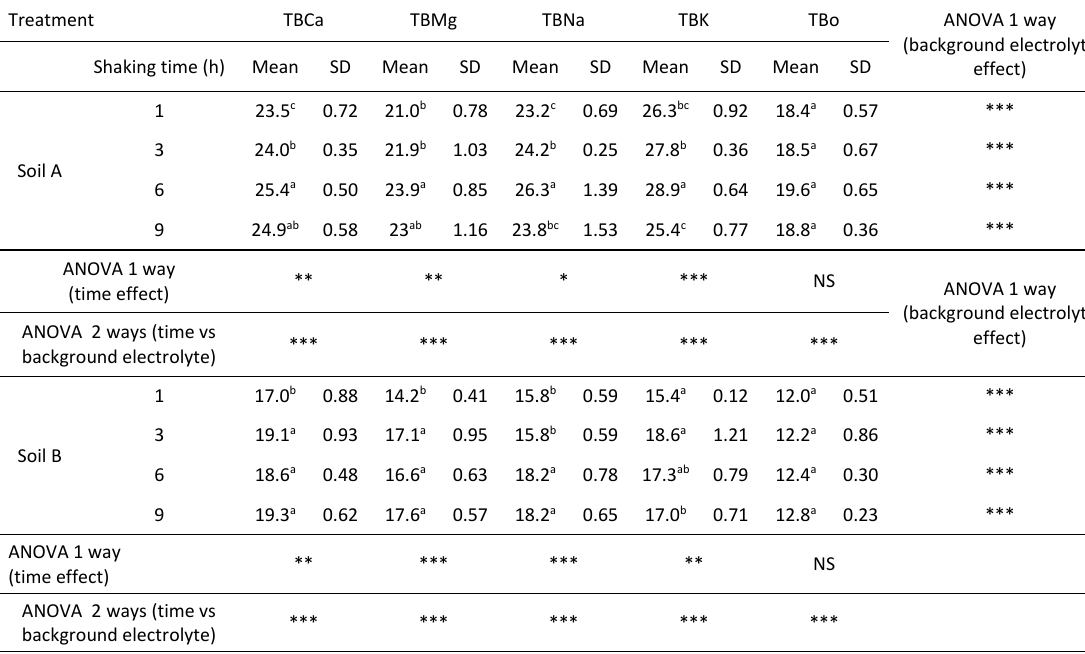
Table 5: B adsorbed (mg B/kg soil), standard deviation, T test and ANOVA 1 and 2 ways in the two soils considering all the treatments (TBCa, TBMg, TBNa, TBK and TBo) and time of shaking